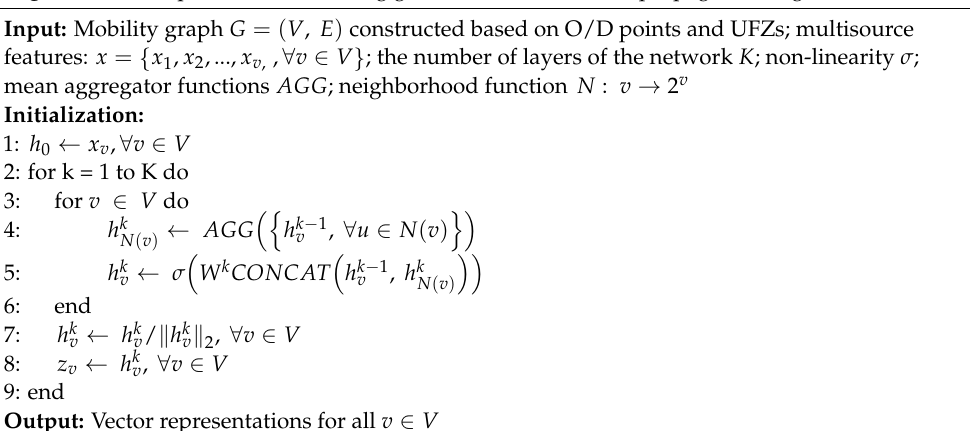
Algorithm 1: Graph SAGE embedding generation (i.e., forward propagation)